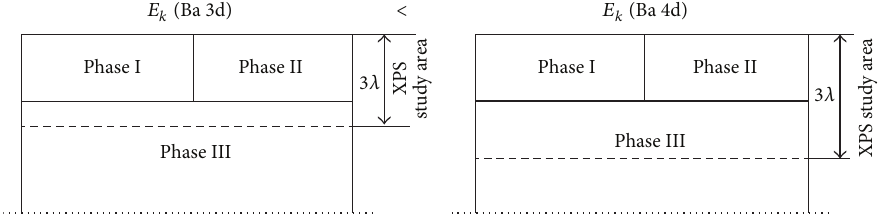
Figure 6: Analysis of the mutual arrangement phases in the surface layer of the material and their volume relations from XPS